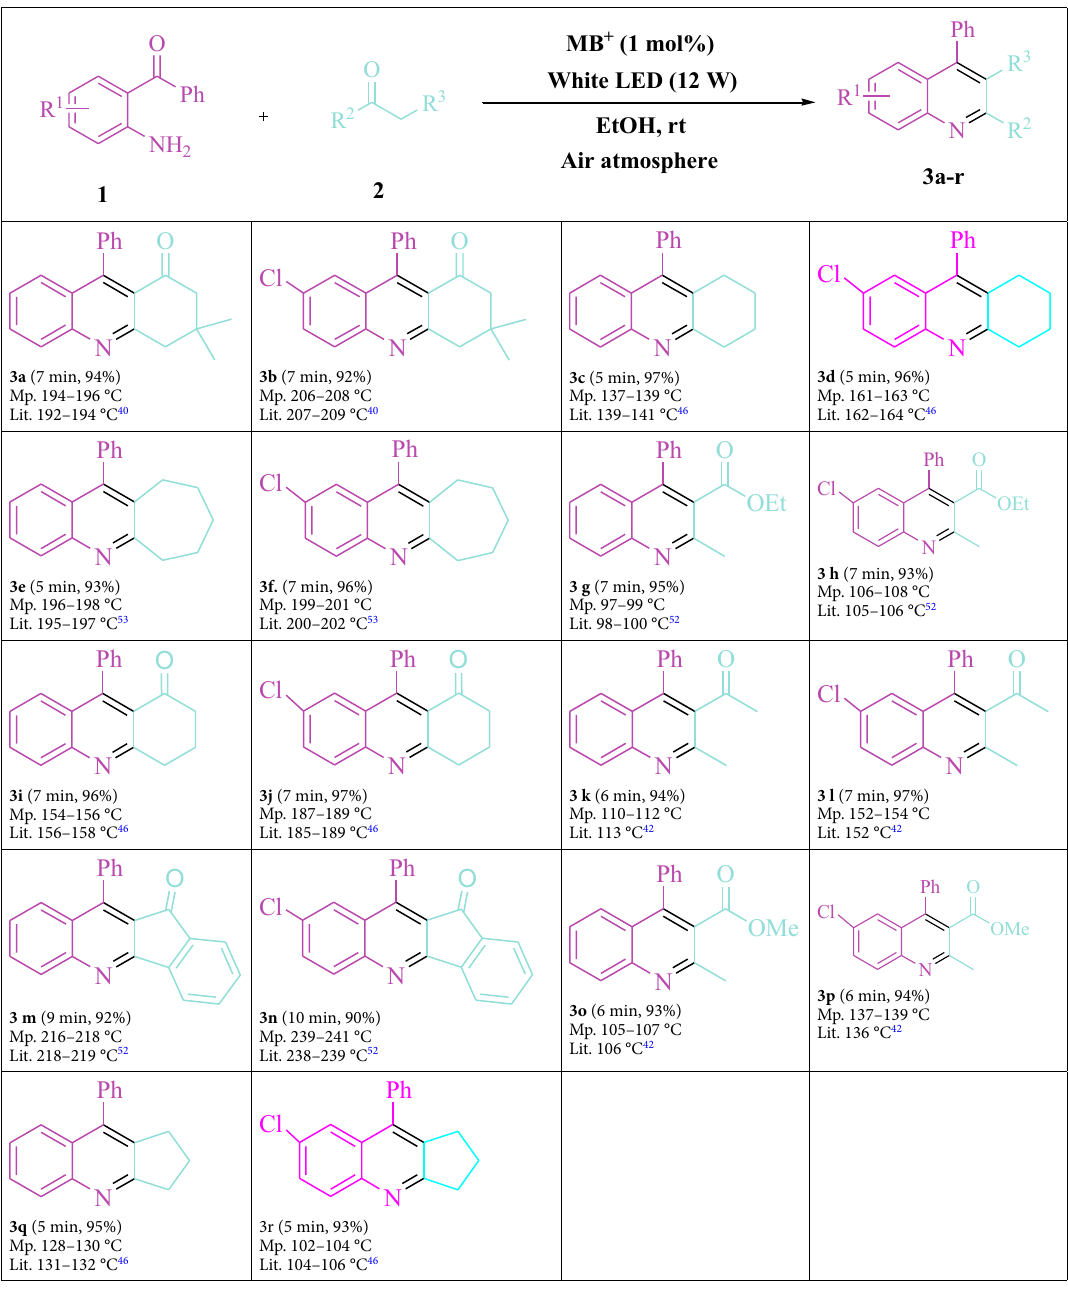
Table 3. Using photoexcited MB + as a catalyst, this photocatalyst produces polysubstitutedquinolines.